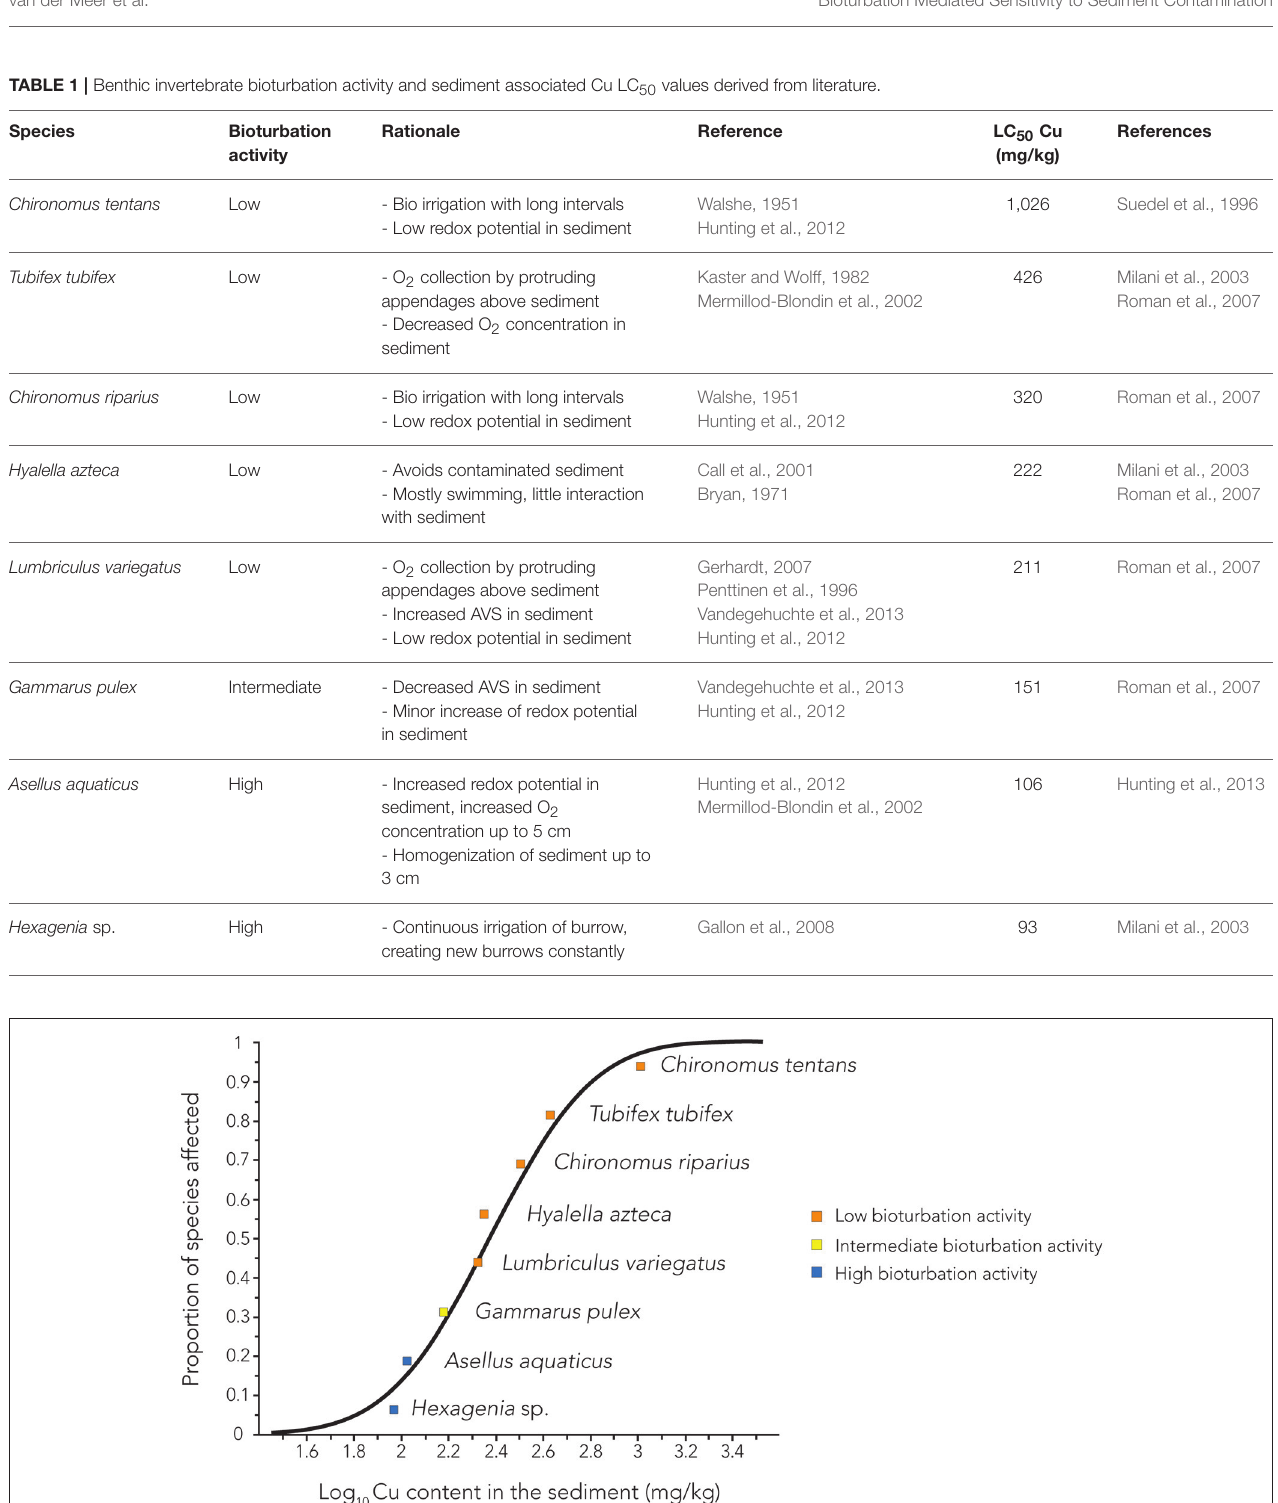
relatively high Cu LC 50 value and being classified as having a low bioturbation rate in the present study, while being relatively sensitive to sediment associated Ni in the study by Vangheluwe